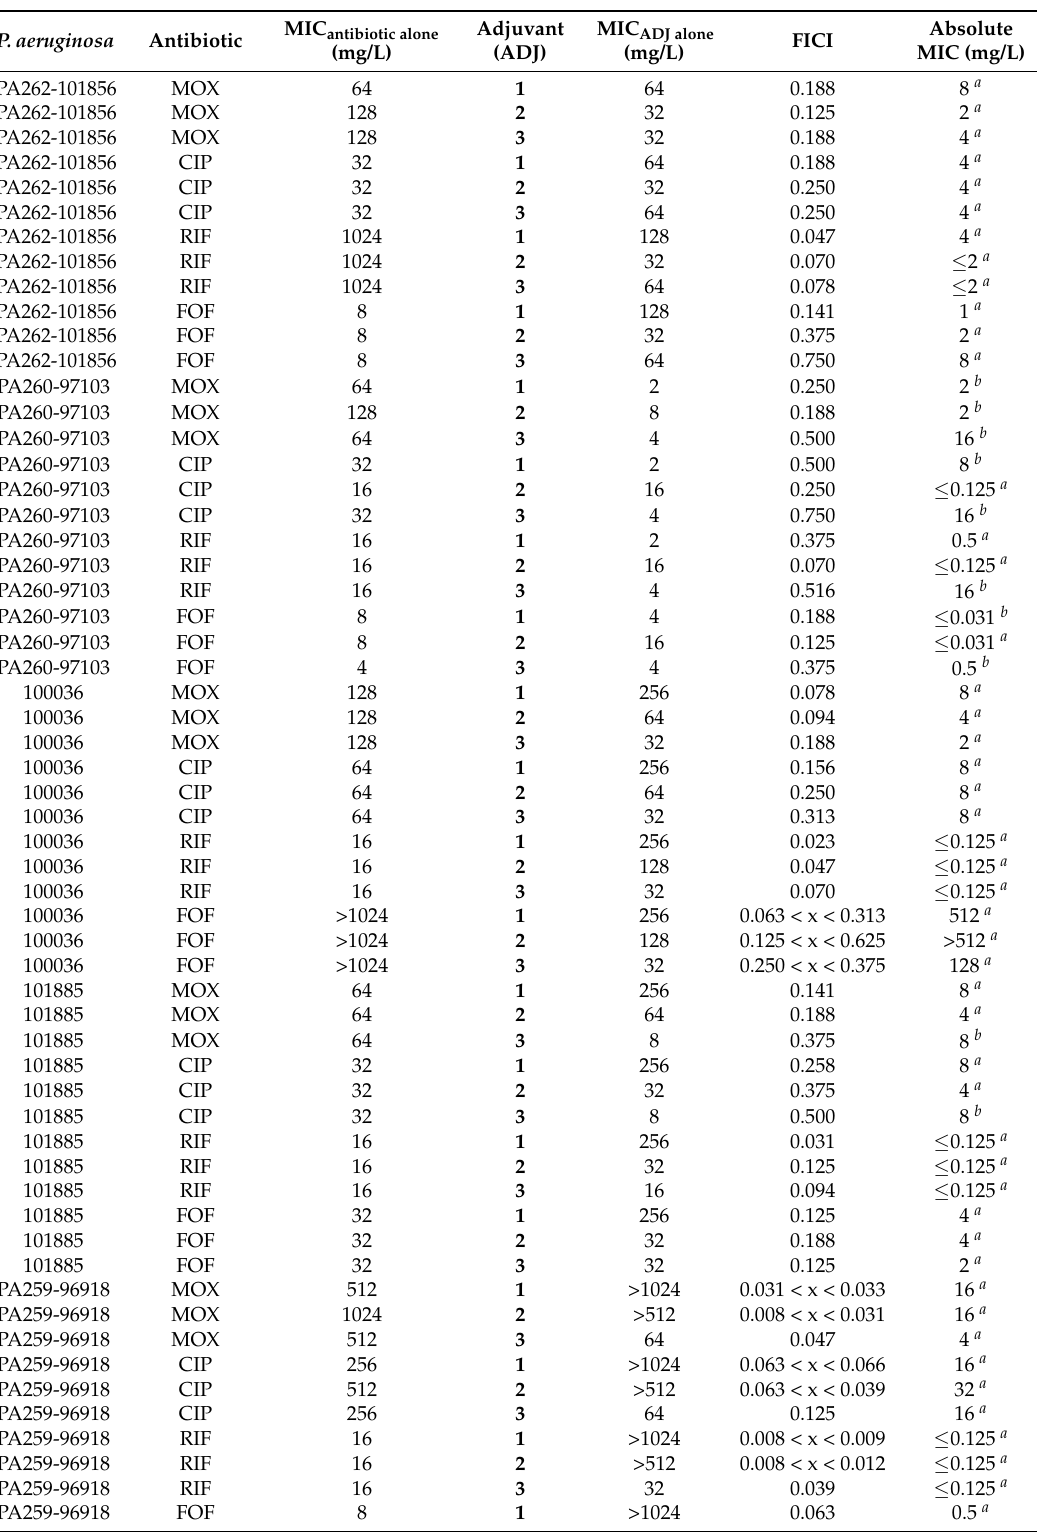
Table 2. Combination studies of TOB-EPIs ( 1 , 2 , or 3 ) with moxifloxacin (MOX), ciprofloxacin (CIP), rifampicin (RIF) or fosfomycin (FOF) against MDR/XDR P. aeruginosa clinical